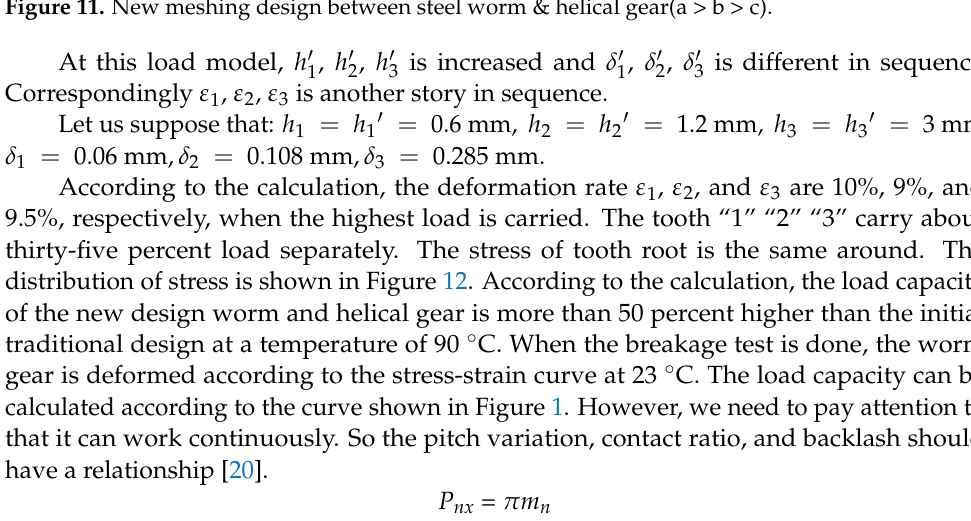
, h (cid:48) , h (cid:48) is increased and δ (cid:48) , δ (cid:48) , δ (cid:48) is different in sequence. 2 3 2 3 1 1